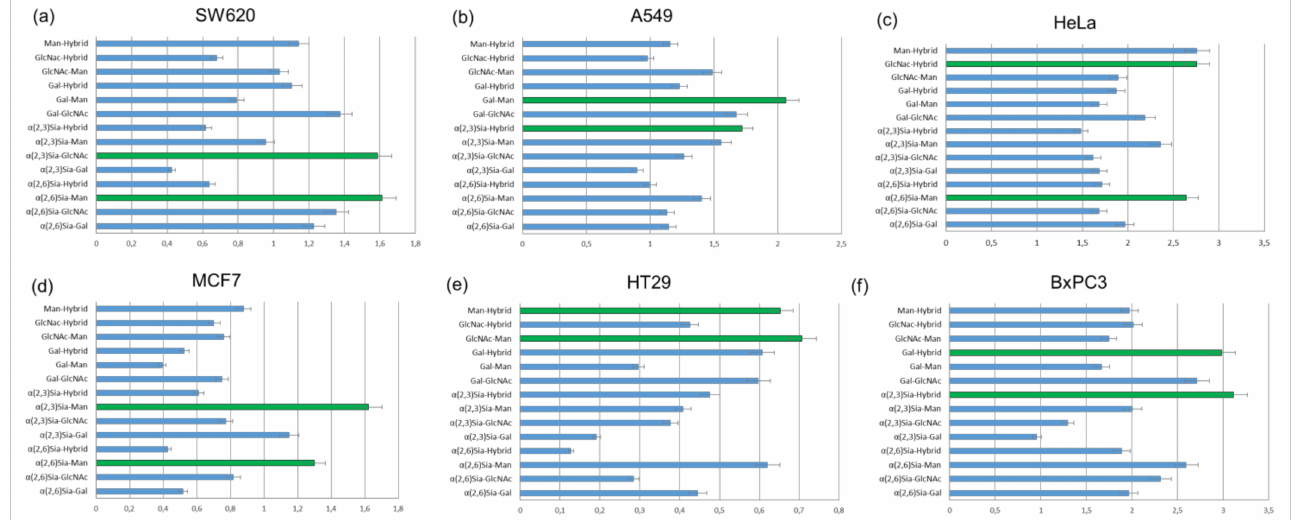
Figure 12. To screen binding affinities, 6 various cancer cell lines were incubated with 14 heteroge- neous glycoconjugates 16ac – ef . The strongest glycoalbumin–cell interactions are colored by green bars. Fluorescence was averaged from 10,000 cells and normalized ( n = 4) [44]. Copyright Wiley-VCH GmbH. Reproduced with